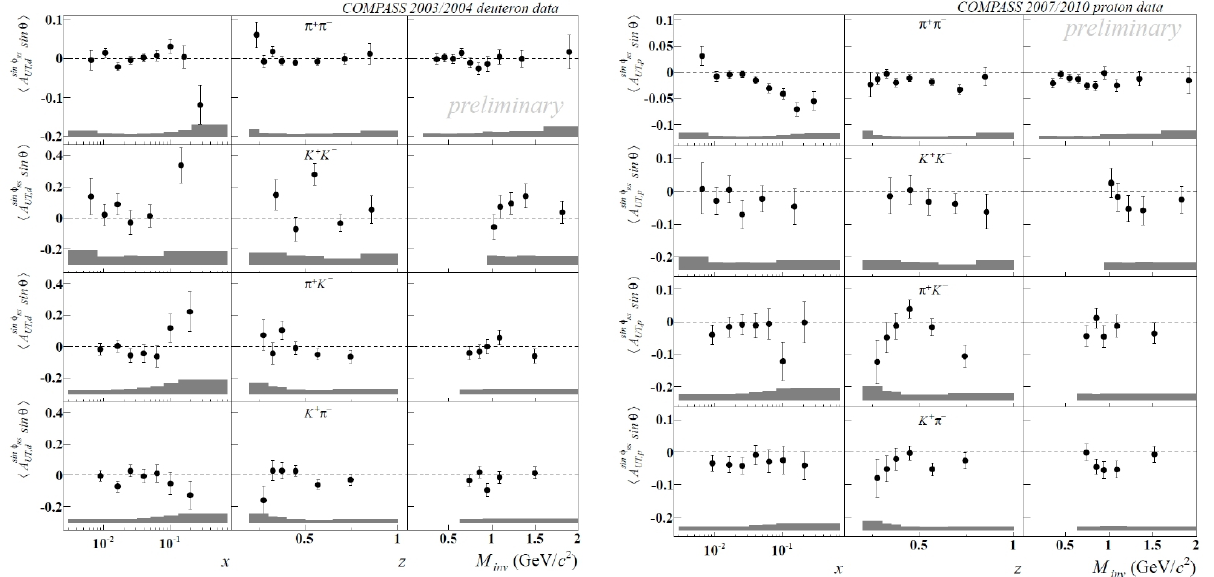
Figure 6. COMPASS measurements of the two identified hadron asymmetries of π + π − , π + K − , K + π − and K + K − on deuterons (left) and protons (right).